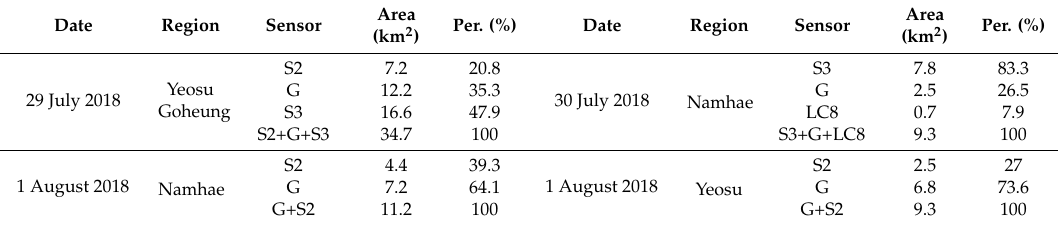
Table 5. Red tide areas extracted from multi-sensor